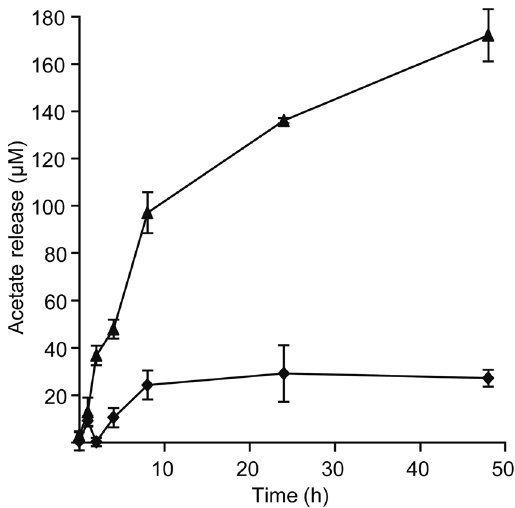
Figure 3. Effect of CBP21 on deacetylation of β -chitin by An CDA. 1 mg/mL β -chitin was incubated with 1 μ M An CDA (diamonds) or with 1 μ M An CDA and 1 μ M CBP21 (triangles) in 50 mM Tris-HCl, pH 8.0 containing 250 µ M CoCl 2 and 1 mM ascorbic acid at 37 °C. In a control reaction with only 1 μ M CBP21 no acetate release was observed. Note that acetate release after 24 hours in the absence of CBP21 corresponds to approximately 0.5% deacetylation.